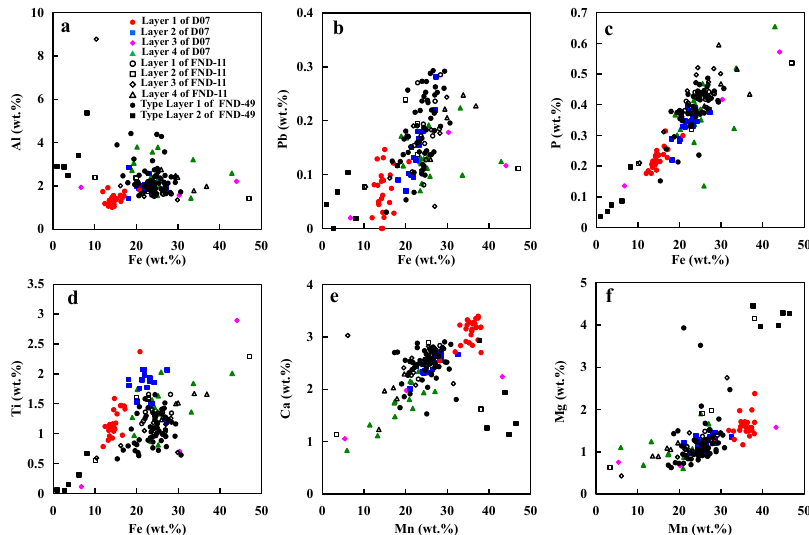
Figure 8. ( a – d ): Relationships of Fe with Al, Pb, P, and Ti; ( e , f ): Relationships of Mn with Ca and Mg.